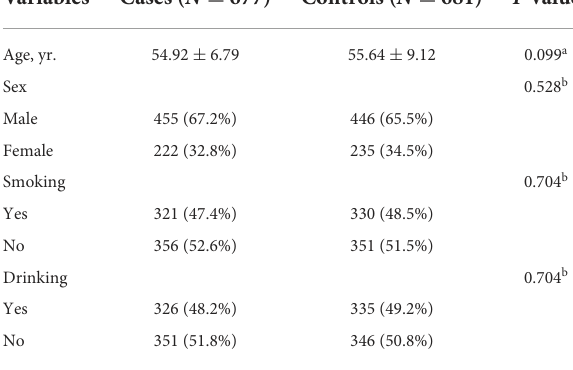
a Pvalueswerecalculatedfromindependentsamplet-test. b Pvalueswerecalculatedfromtwo-sided χ 2 test. P <